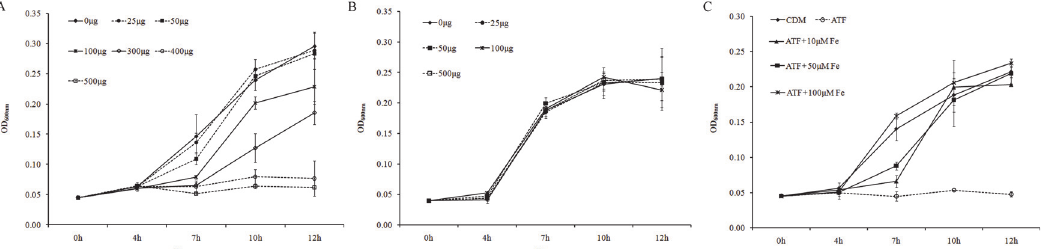
Fig 3. The effect of transferrin on A . pleuropneumoniae growth in CDM). A . pleuropneumoniae was cultured in TSB medium overnight and then sub- cultured into CDM at an inoculation dose of 10 4 CFU/ml. Optical densities of bacterial cultures (OD 600nm ) were recorded at selected time points. Various concentrations of apo-transferrin (ATF) (A) or holo-transferrin (HTF) (B) were added into CDM. (C) . ATF at 400 μ g/ml was added into CDM (ATF) and FeCl 3 at different concentrations were supplemented into the medium containing ATF (ATF + Fe). A . pleuropneumoniae cultured in CDM without any supplementation was used as a control (CDM). Data are shown as means ± SD from four independent replications.